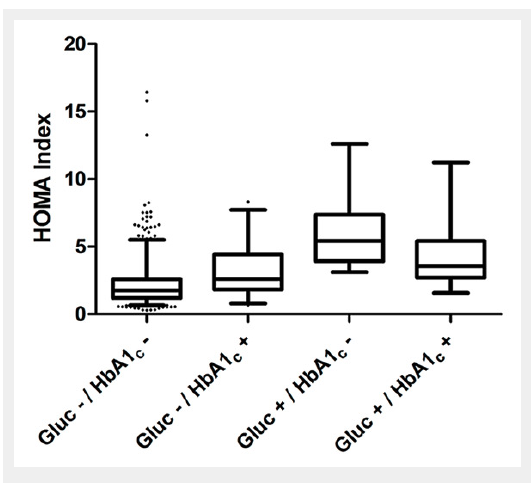
Prevalence of unknown prediabetes (PreD) and type 2 diabetes mellitus (T2DM) by age group. The prevalence of impaired fasting glucose (suppositious PreD) and T2DM continued to increase with age older than 60 years, and there is a curve exhibiting saturation characteristics from age 80 years onwards.